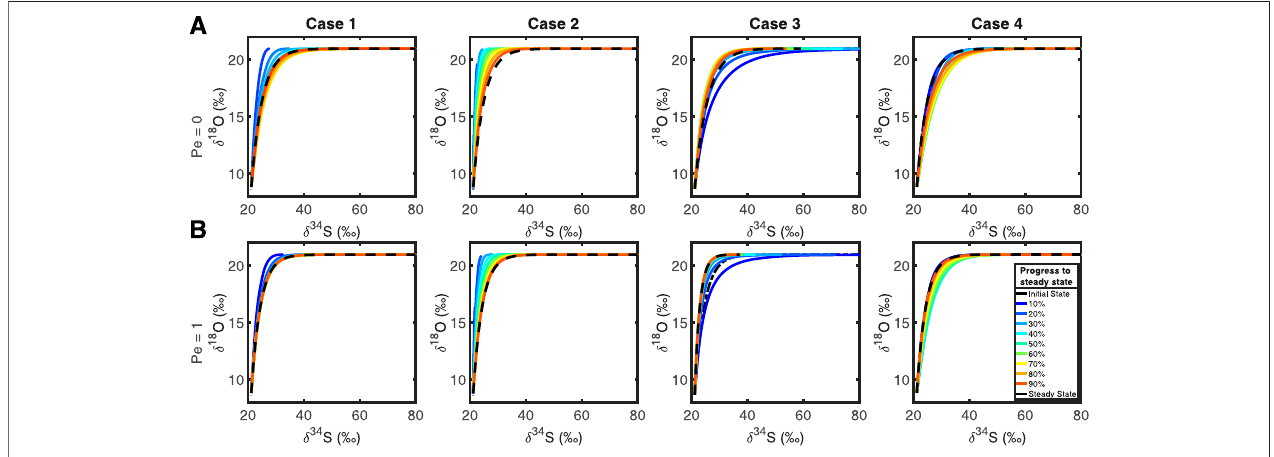
FIGURE7| Toprow, (A) :Plotsof δ 34 Sagainst δ 18 Oinextracellularsulfatewithoutanadvective fl ux(Pe (cid:2) 0).Bottomrow, (B) :Crossplotsof δ 34 Sagainst δ 18 Owithanadvective fl uxof24.09 km Ma − 1 (Pe (cid:2) 1),ineachtestcase.Comparingthetopandbottomrowsdemonstratesthatadvectionhasnosigni fi canteffectonthenatureoftheisotopecrossplots.